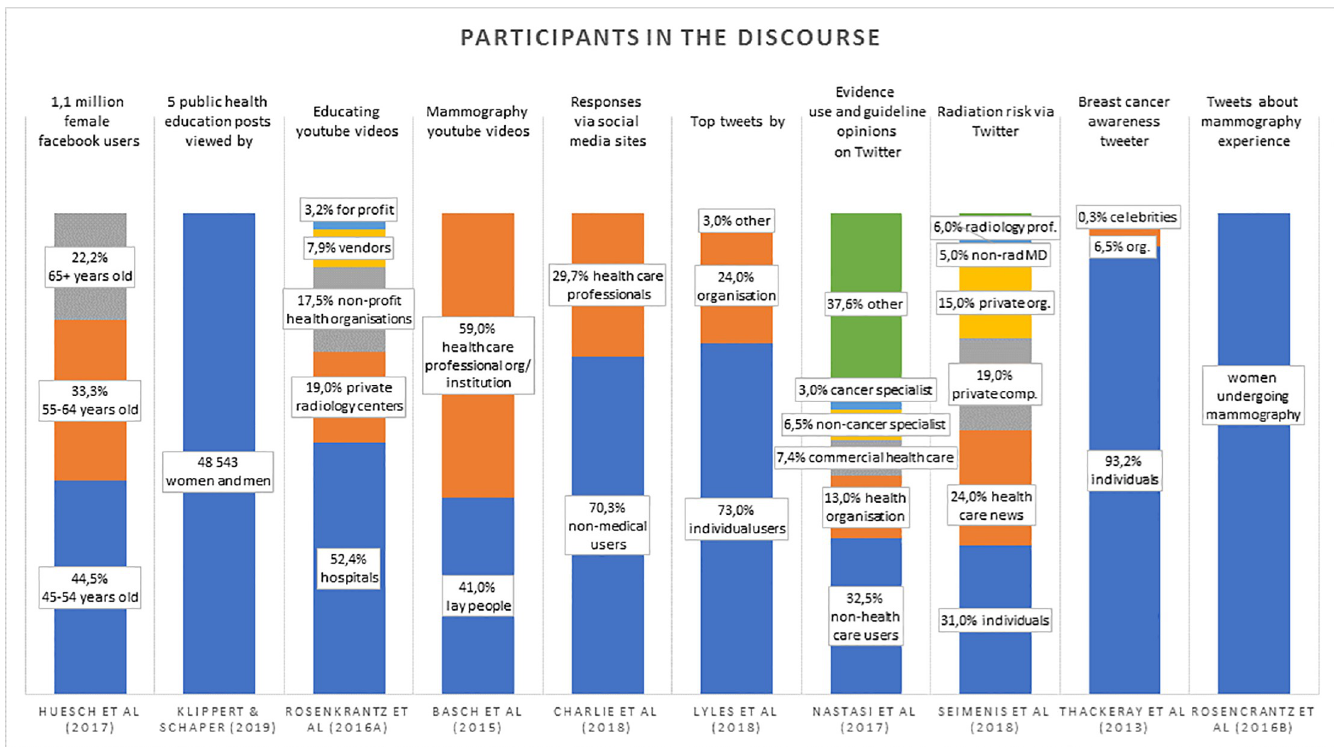
Fig 2. (Participants in the discourse) should be linked